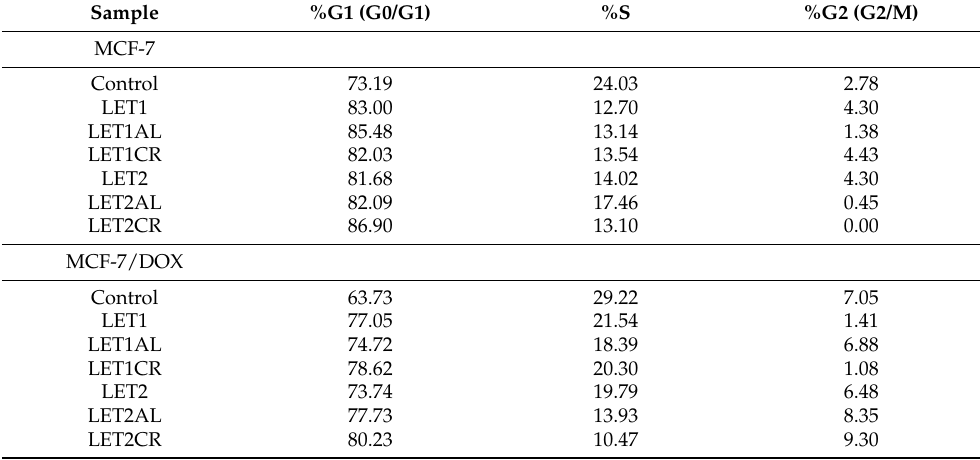
Table 2. The effect of letrozole and its combination with metalloestrogens on the cell cycle in MCF-7 and MCF-7/DOX cell lines. LET 1 = 10 µ M; LET 2 = 100 µ M; and Al/Cr(III) = 100 µ M. The results are presented as mean, n =